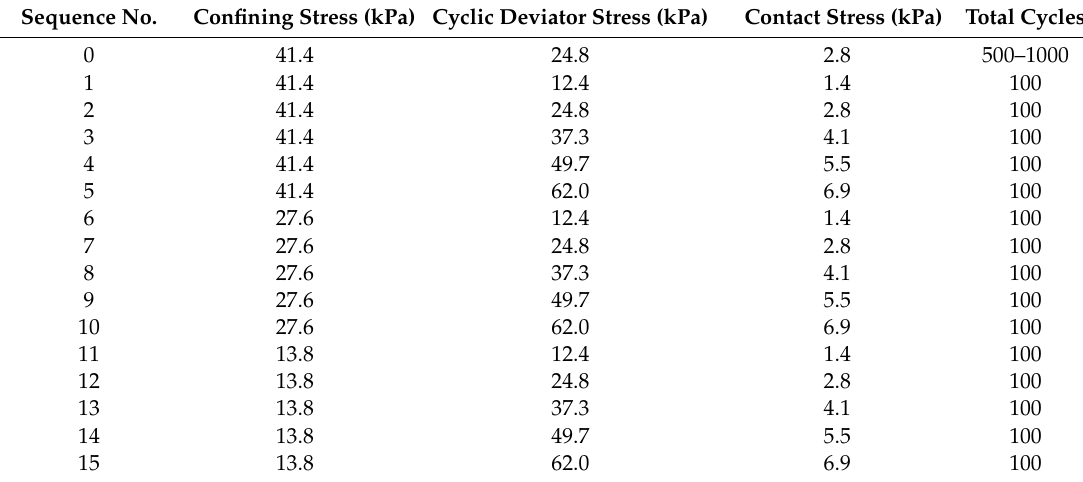
Table 3. Loading sequences used in cyclic triaxial